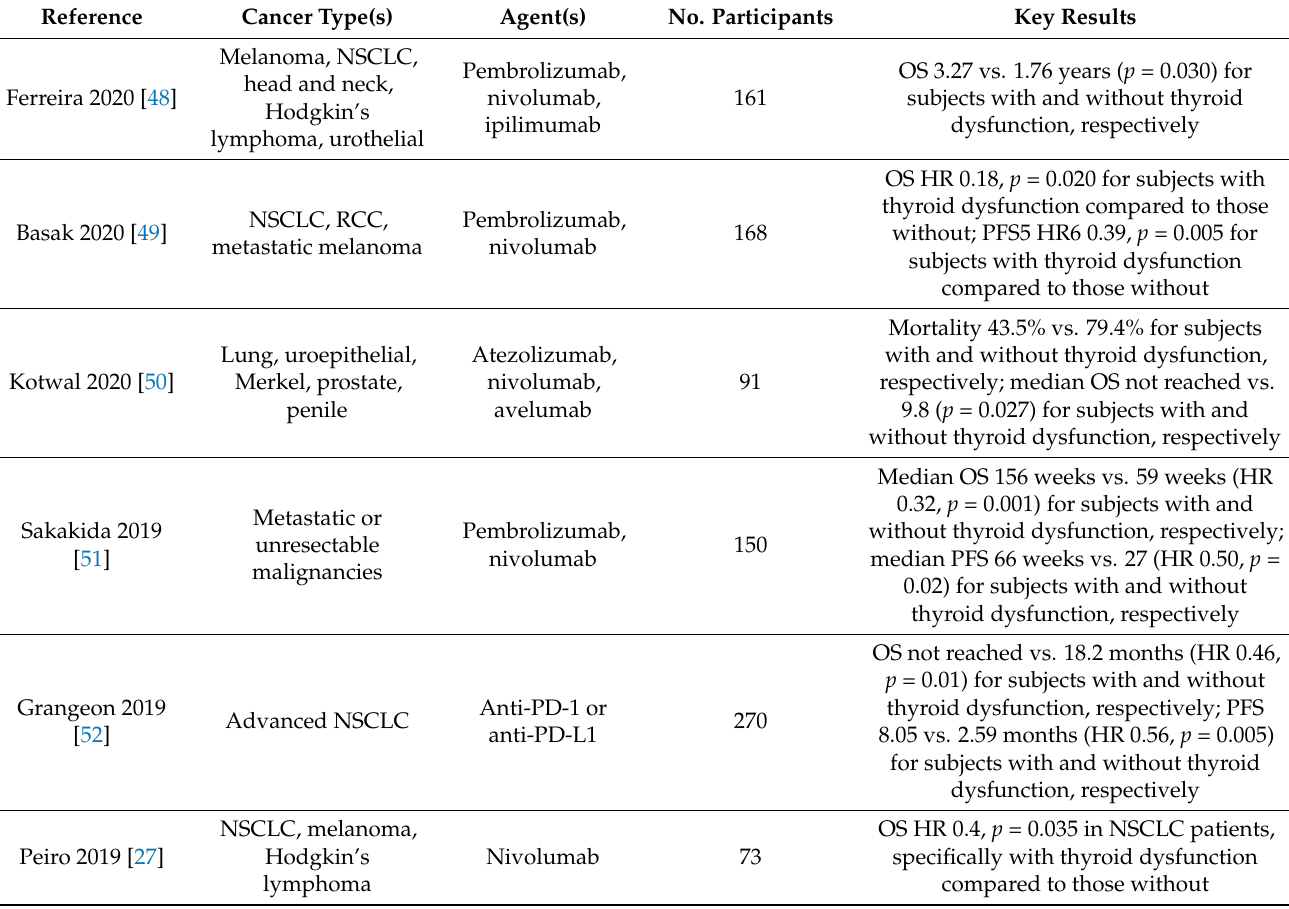
Table 4. Studies investigating the relationship of thyroid irAEs with survival